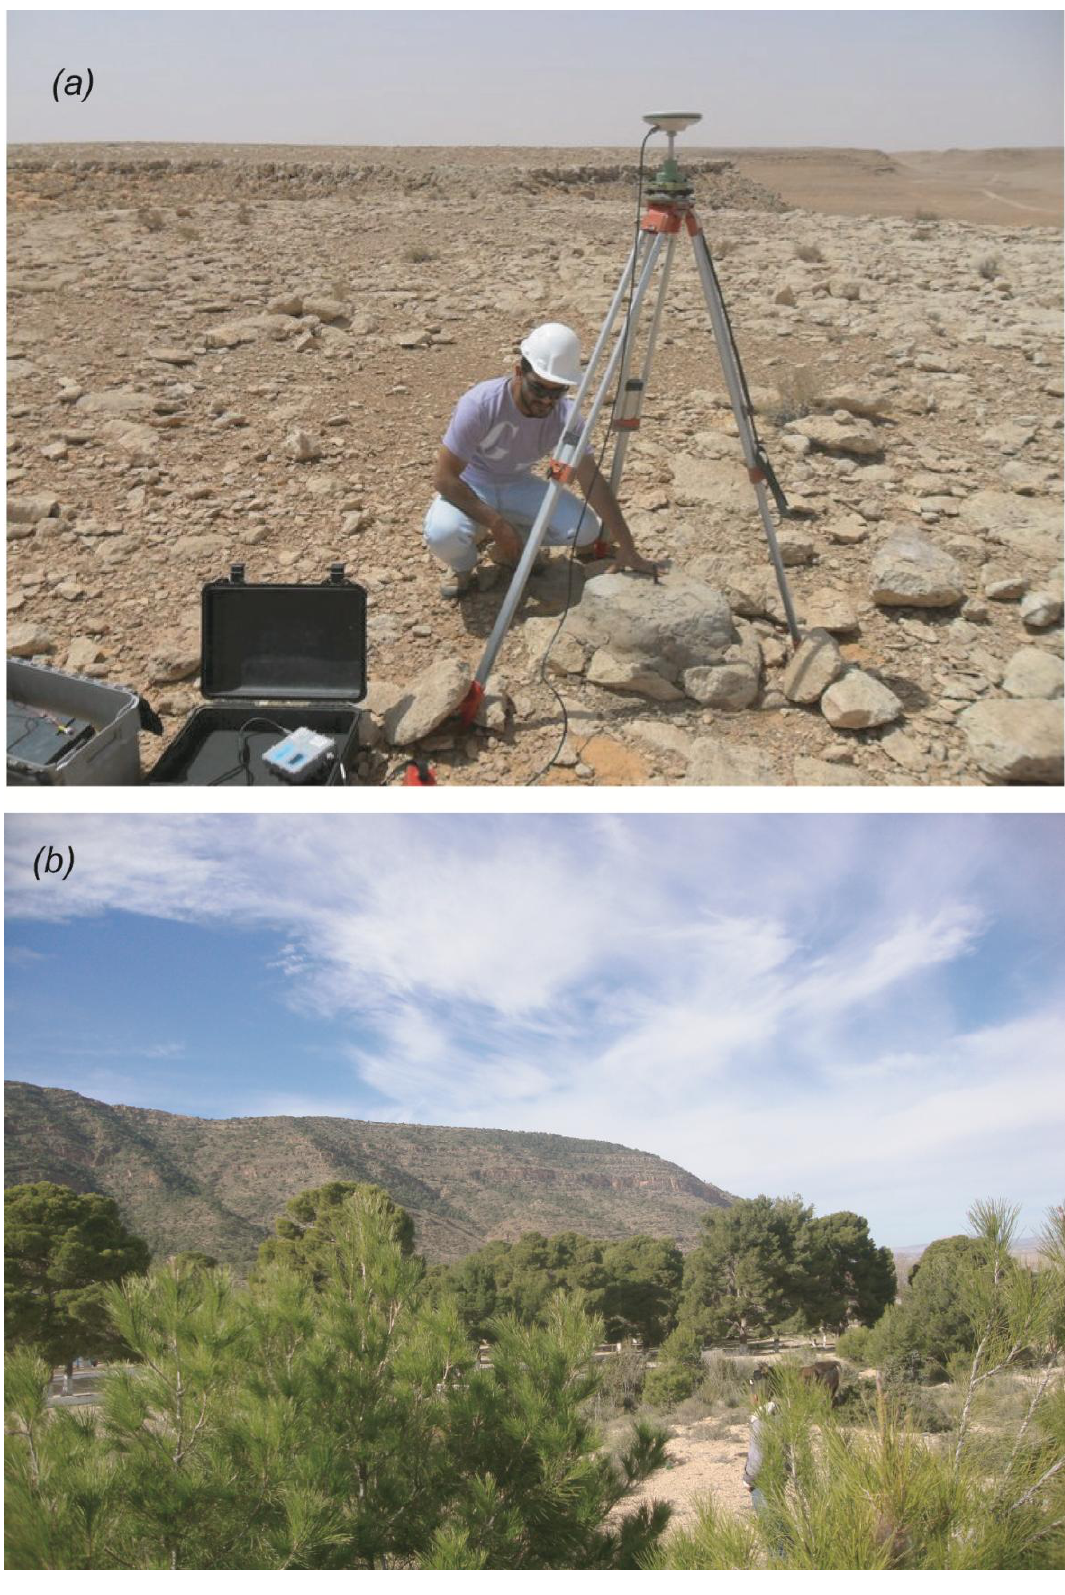
Figure 2. Landscape characteristics of the ( a ) Anaguid Saharan platform and ( b ) Tebessa Basin. Note the GPS base station photo in